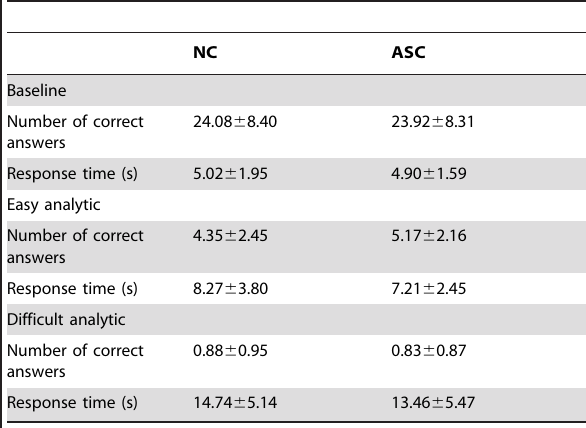
Table 2. Behavioral